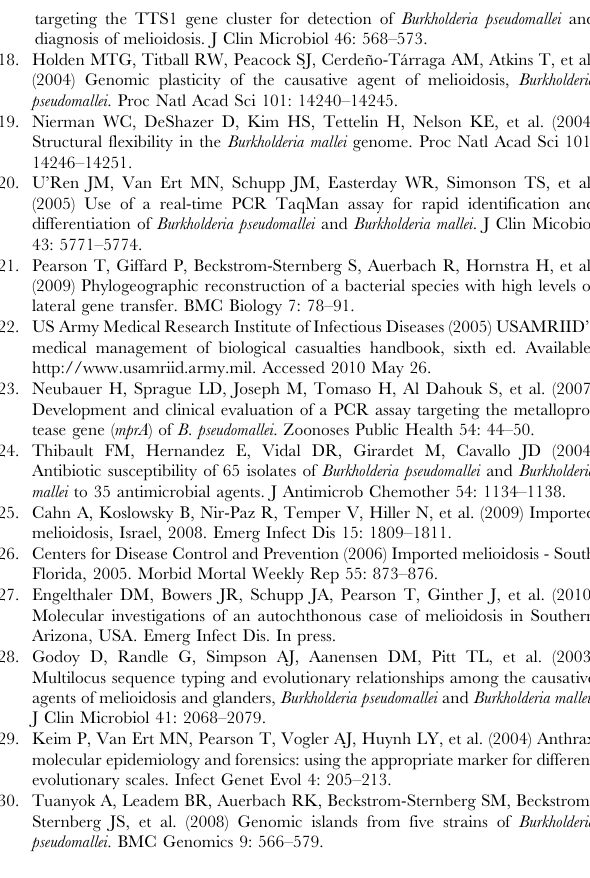
Figure 2. Amplification plots of BurkDiff. Quadruplicates of 10-fold serial dilutions of DNA from a crude heat lysis extraction of A. B. mallei strain 2002734303 and B. B. pseudomallei strain 2002721637 were screened on BurkDiff to determine the limit of detection of the assay. Two of 4 replicates at the 10 1 copies template amount did not amplify for both species.